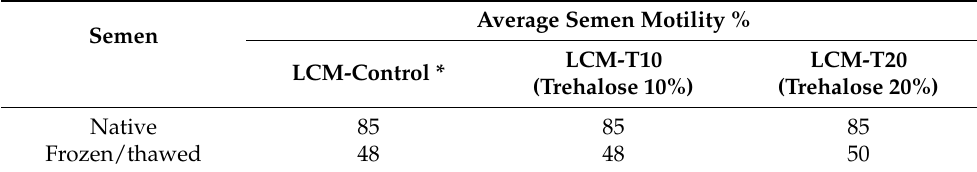
Table 3. Egg fertility rates (%) obtained by artificial insemination of hens with frozen/thawed rooster semen using different concentrations of trehalose in the diluent. Medium Eggs Laid, psc.